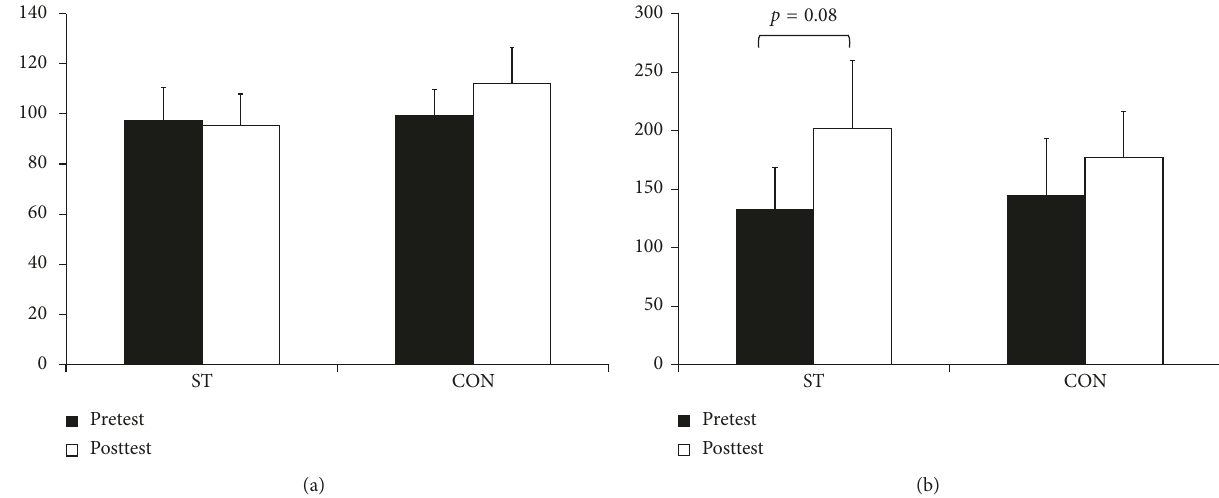
Figure 4: The pre- and posttest results of the (a) maximal strength and (b) RFD in arm flexion for the strength-training group (ST) and control group (CON). All values are presented as mean ± SE. ∗ Within-group differences, p < 0 .